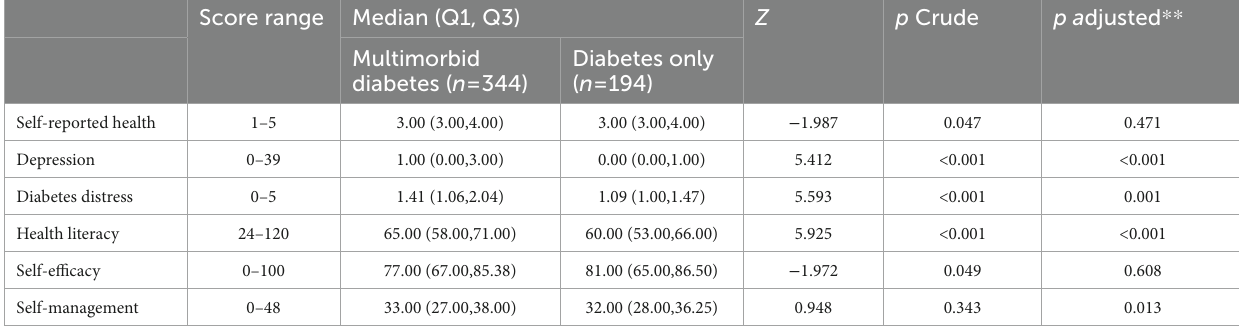
TABLE 2 Health-related abilities and problems of elderly, multimorbid patients with diabetes versus elderly patients with diabetes only ( N =